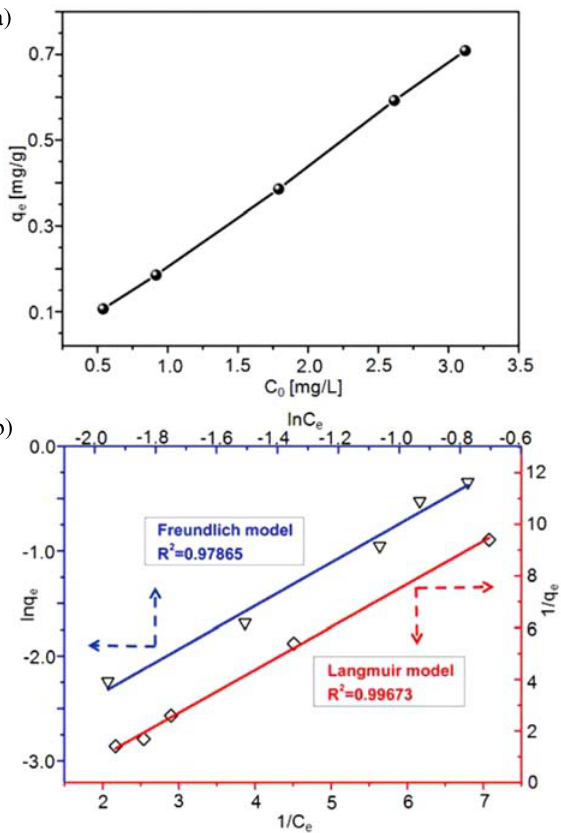
Figure 6. (a) Effect of adsorption time on adsorption capacity of MnO /ESM in MB solutions. (b) Pseudo-first-order (red line) and 2 pseudo-second-order (blue line) models for MB adsorption.